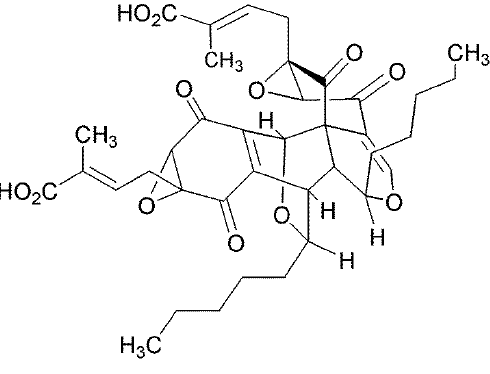
Figure 6. The structure of torreyanic acid.